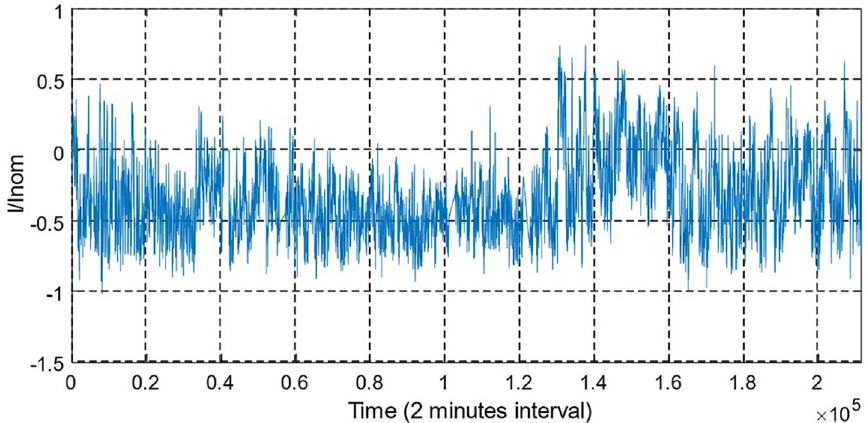
Figure 52. Evolution of the load factor.